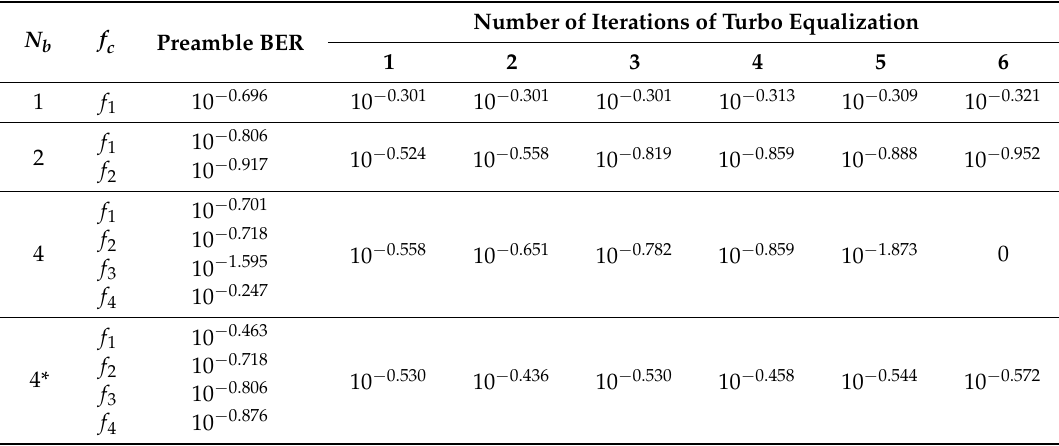
Figure 7. Flowchart for the performance evaluation procedure. Table 2. The Bit Error Ratio (BER) performance of Experimental results.